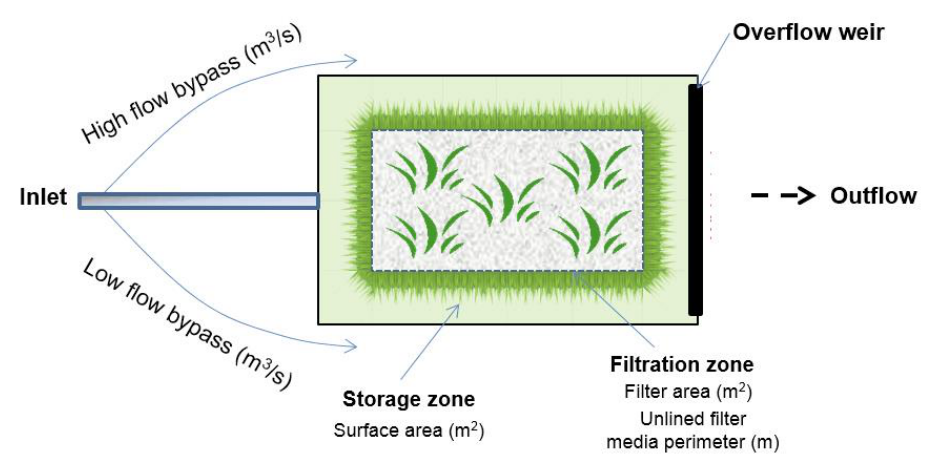
Figure A3. The schematic diagram of bioretention areas [112]. Table A3. Parameters of three types of bioretention areas in MUSIC.